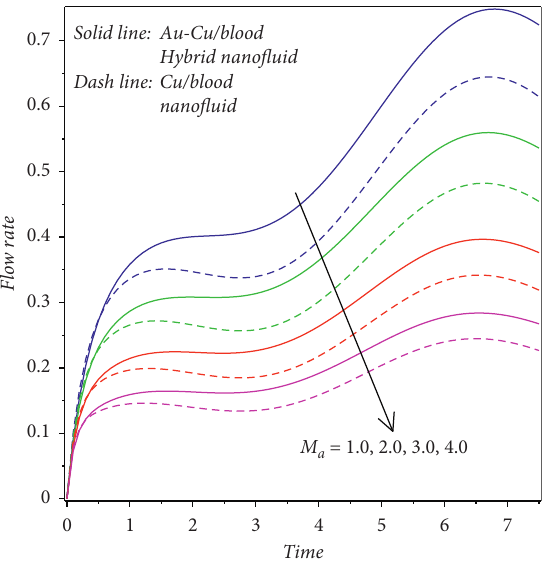
Figure 16: Behaviour of G